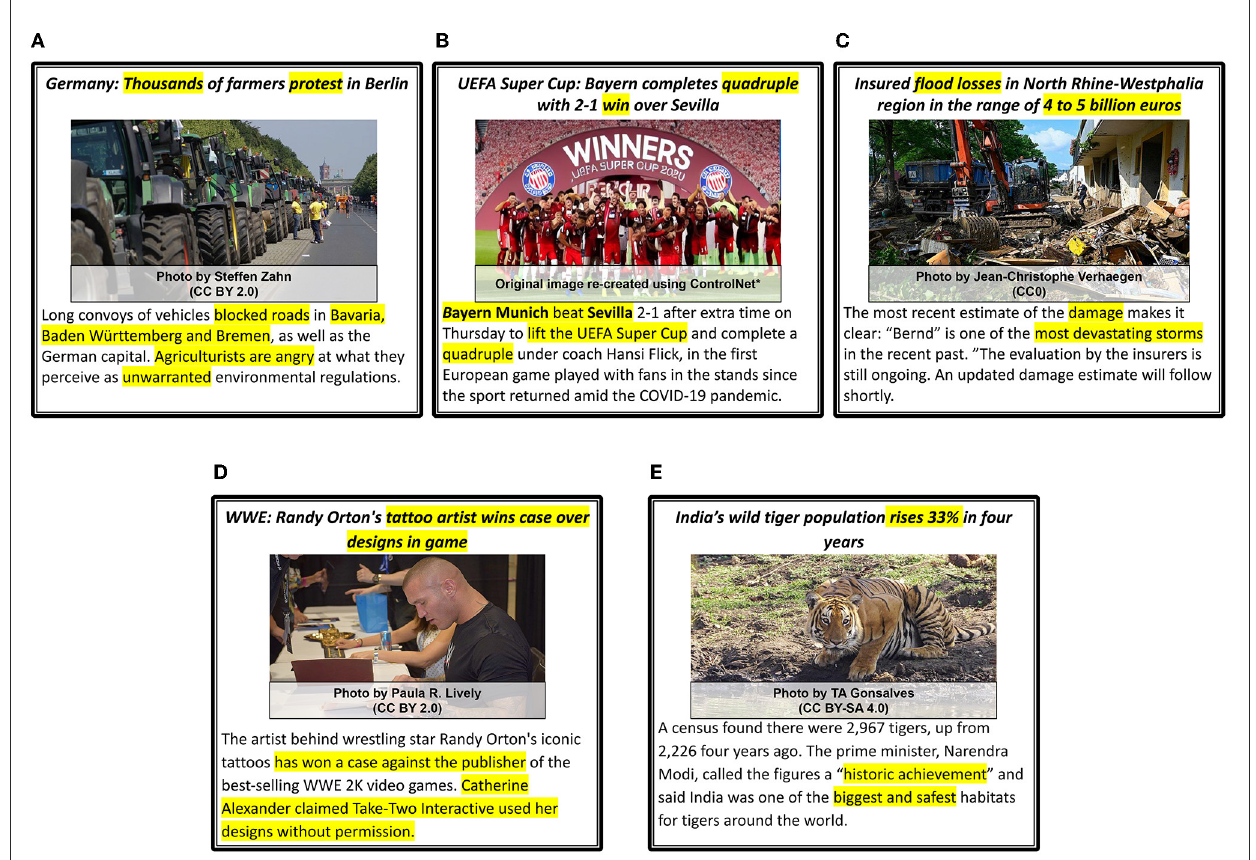
FIGURE11 Sentiment , Superlativeness and Impact news values examples. All news values are described as Category , (textual or visual cues), [Modalities: I (image), T (Text)] . The segments in text that mention important words or phrases that indicate quantifiers, adjectives, mentions of disasters, etc. are highlighted (yellow). *Used ControlNet (Zhang and Agrawala, 2023) to re-create images because of licensing issues. (A) Sentiment : Negative, (Angry, unwarranted), [T], Superlativeness : Yes, (Thousands, tractors) [I,T], Impact : Medium, (protest, blocked roads in..) [I,T]. (B) Sentiment : Positive, (Win, celebration, happy), [I,T], Superlativeness : Yes, (multiple players, happy), [I], Impact : Medium, (win, celebration), [I,T]. (C) Sentiment : Negative, (losses, devastating), [I,T], Superlativeness : Yes, (heaps of trash, billion euros) [I,T], Impact : High, (damage, most devastating), [I,T]. (D) Sentiment :